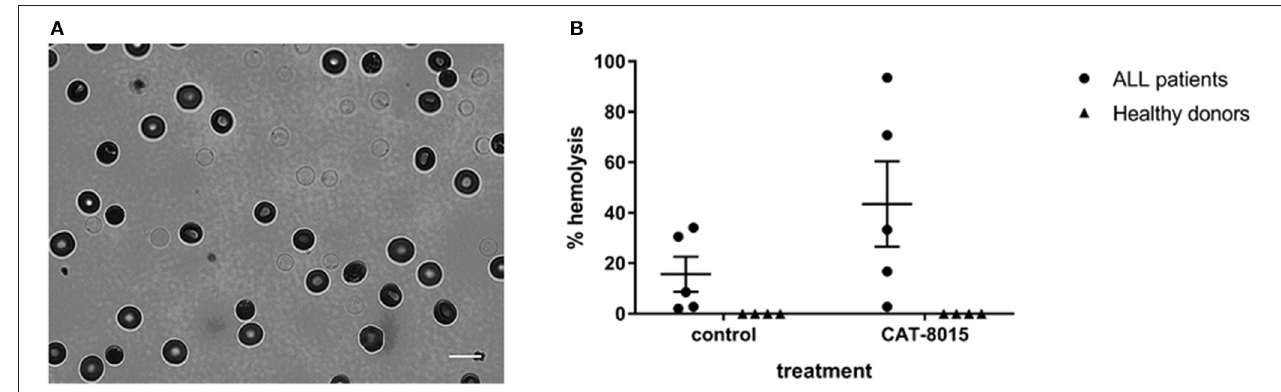
FIGURE 3 | CAT-8015-induced lysis of RBCs from ALL patients . (A) A typical 415nm light image of Di-8-ANEPPS-labeled RBCs from ALL patients after incubation with CAT-8015 for 1h at room temperature. Lysed cells appear with faint outlines of their membranes, while live cells appear with a halo around their edge. Bar represents 10 µ m. (B) Haemolysis profiles of Di-8-ANEPPS-labeled RBCs from ALL patients ( n = 5) and healthy donors ( n = 4) after incubation for 1h at room temperature with buffer only (control) or buffer containing CAT-8015. The % lysed cells after each treatment was determined by counting individual RBCs within each population before and after incubation with buffer only (control) or buffer containing CAT-8015. At least 30 cells per treatment were